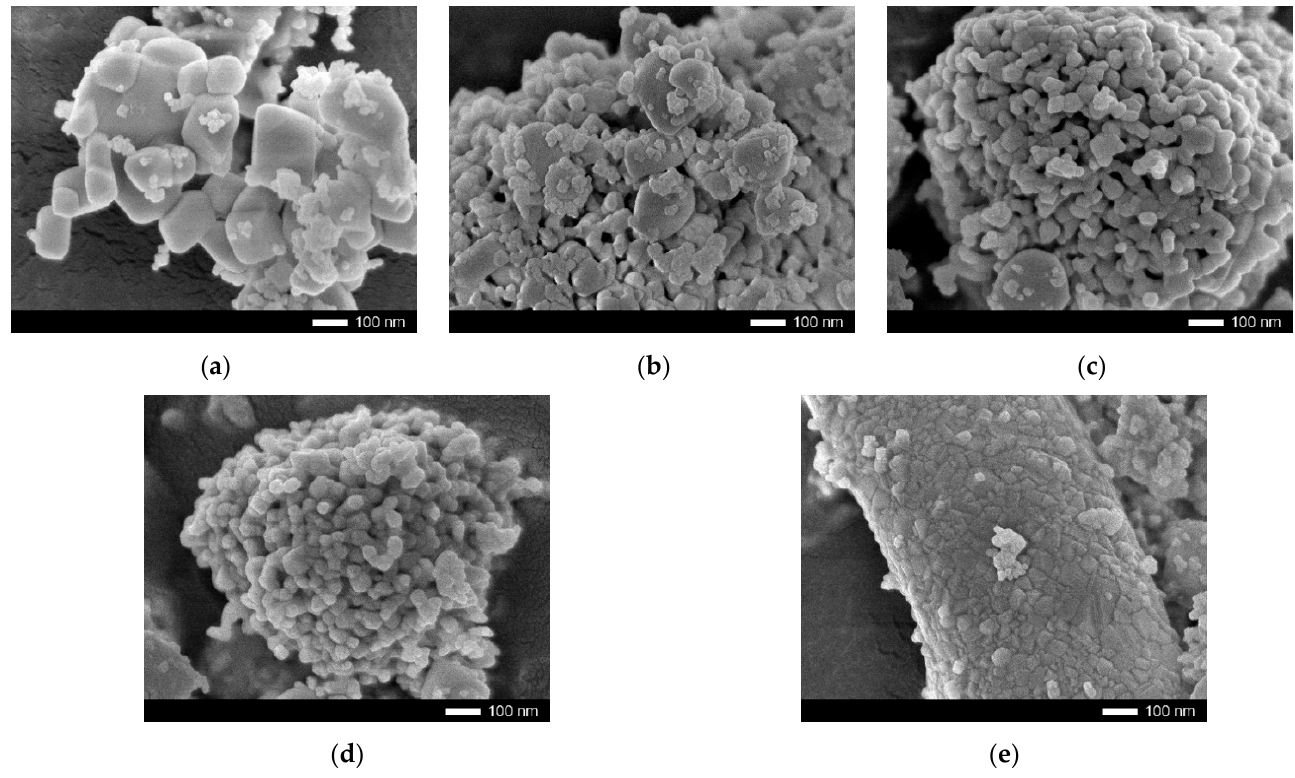
Figure 1. SEM images of morphological features of ZrO 2 —CeO 2 ceramics, depending on the concentration of the yttrium dopant: ( a ) 0.00 mol, ( b ) 0.10 mol, ( c ) 0.15 mol, ( d ) 0.20 mol and ( e ) 0.25 mol.